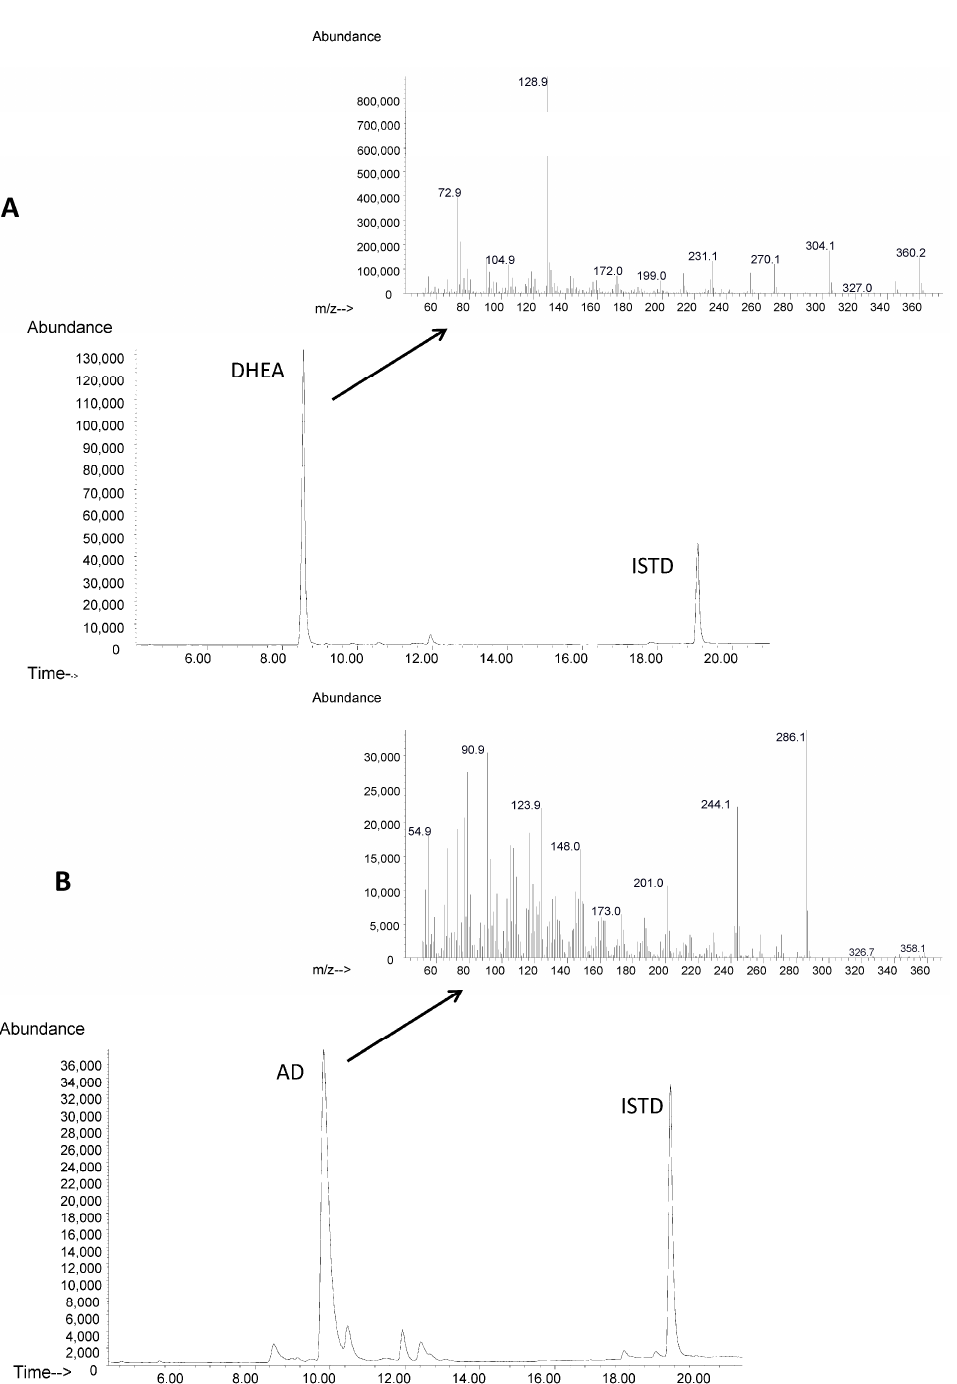
Figure 2. Transformation of DHEA into AD by C. glutamicum R31 (pCGL5228). Cells of C. glutamicum (pCGL5228) were incubated in a resting ‐ cell medium for 28 h with 2 mM DHEA at 30 °C. ( A ) Analysis by GC ‐ MS of the reaction products at 0 h and fragmentation pattern of DHEA. ( B ) Analysis by GC ‐ MS of the reaction products after 28 h and fragmentation pattern of AD. ISTD: internal standard.